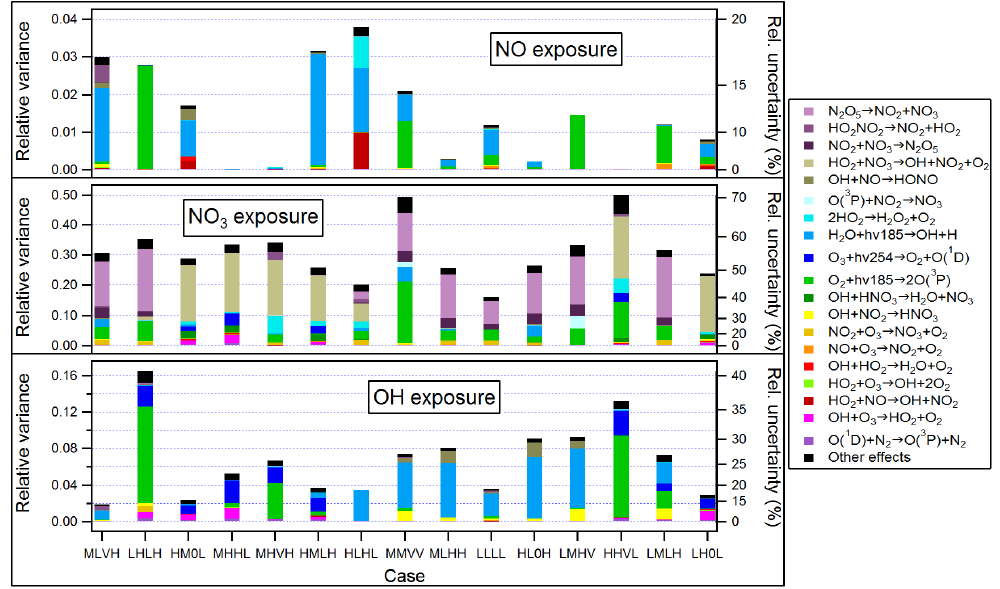
Figure 2. Relative variances (left axes) and uncertainties (right axes) in several outputs (i.e., NO, NO 3 , and OH exposures) of Monte Carlo uncertainty propagation and relative contributions of key reactions to these relative variances in several typical cases (denoted in four- character labels; see Table 2 for the typical case label code) in OFR185-iNO. Relative variances are shown in linear scales (left axis), while corresponding relative uncertainties equal to relative variances’ square roots are indicated by the nonlinear right axis. Only the reactions with a contribution of no less than 0.04 to at least one relative variance are